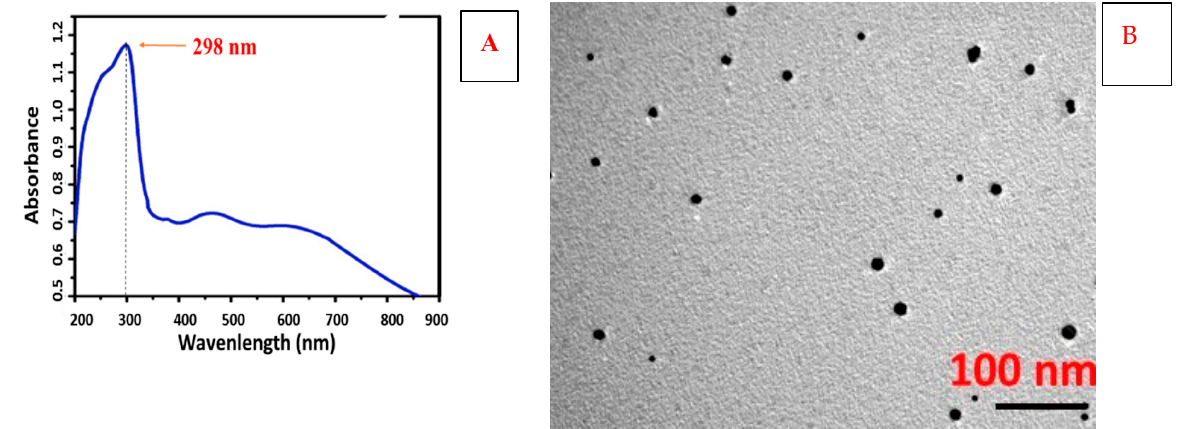
Figure 1. UV–Vis graph and TEM image of iron oxide NPs used in the experiment. ( A ) UV-Vis diagram showing absorbance peak at 298 nm ( B ) TEM diagram showing structural details of IONPs used in the current experiment. Table 3. Characterization of iron oxide NPs.